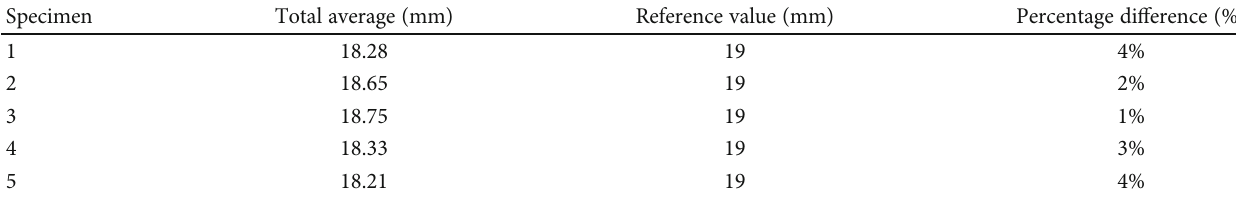
Table 12: Overall width ( WO ) of the test